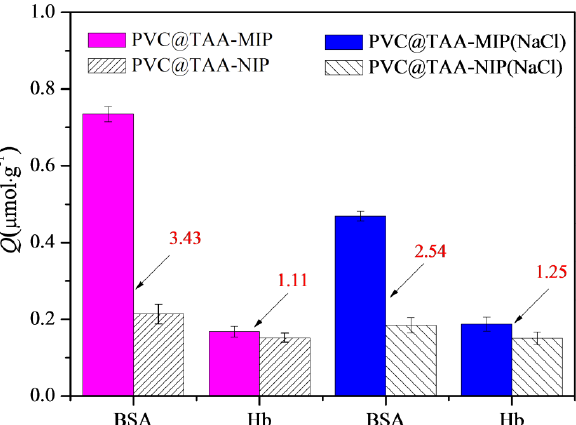
Figure 9. Competitive binding results for BSA and Hb to PVC@TAA − MIP and PVC@TAA − NIP in absence or presence of NaCl.